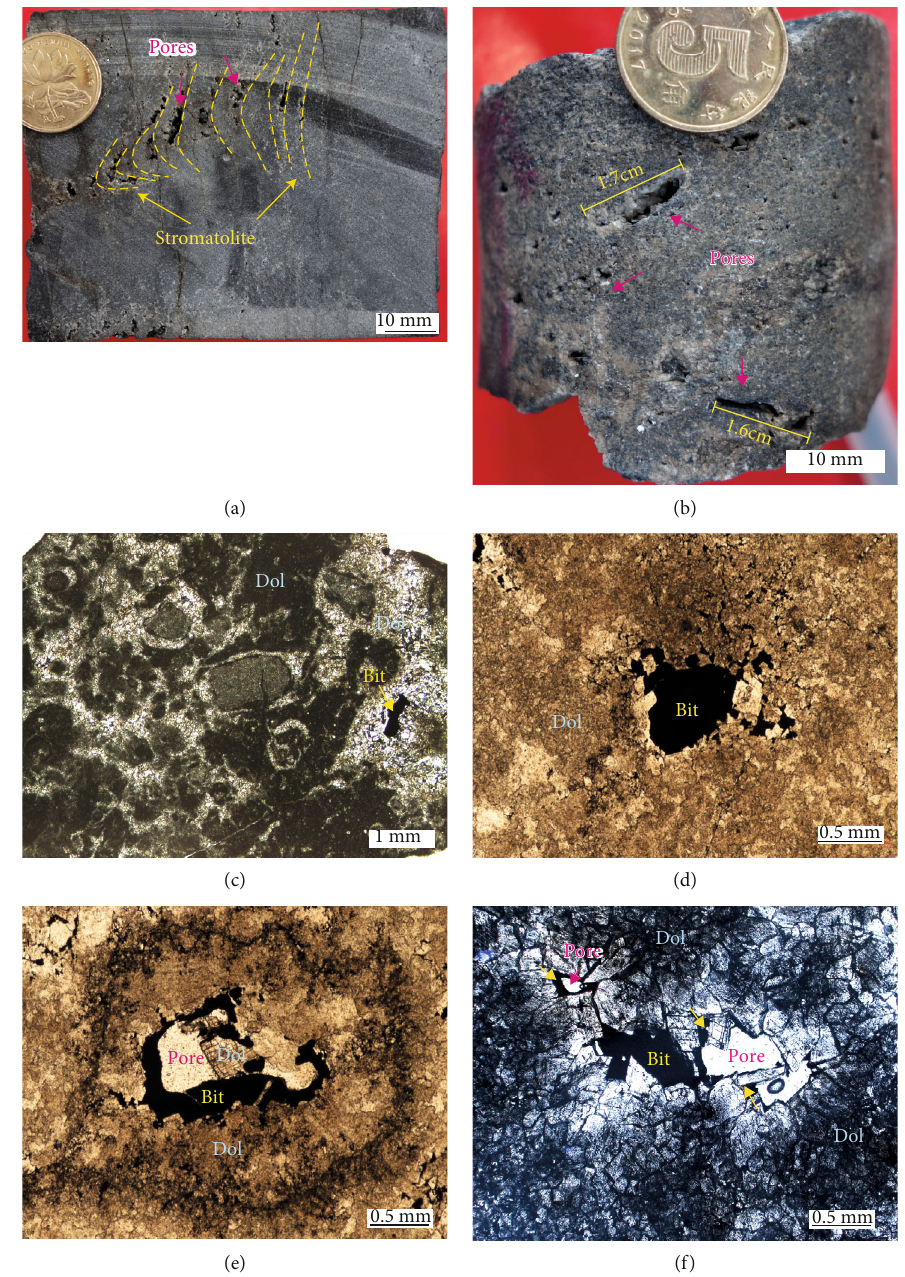
Figure 2: Lithology and pore characteristics of the CS well #1 Z dn 4 member reservoir. (a) Algae stratiform dolomite, solution pore-fracture 2 distribution along the algae stratiform stack, CS well #1, 8,160.29 – 8,160.36 m; (b) algae-coagulated dolomite; cm- and mm-scale pore/solution pore development, CS well #1, 8,157.96 – 8,158.07m; (c) algae-coagulated dolomite, solution pores developed in the fi ne- grained dolomite cement between microbial fabrics, fully fi lled with bitumen, CS well #1, 8,162.15m; (d) solution pores developed in crystalline powder dolomite, fully fi lled with bitumen, CS well #1, 8,157.96 m; (e) pulverised dolomite solution pores, recrystallised dolomite and bitumen semi- fi lled dissolution pores, hollow centre, CS well #1, 8,159.12 m; (f) pulverised dolomite intergranular solution pores, bitumen semi fi lled solution pores, hollow centre, CS well #1, 8,159.95